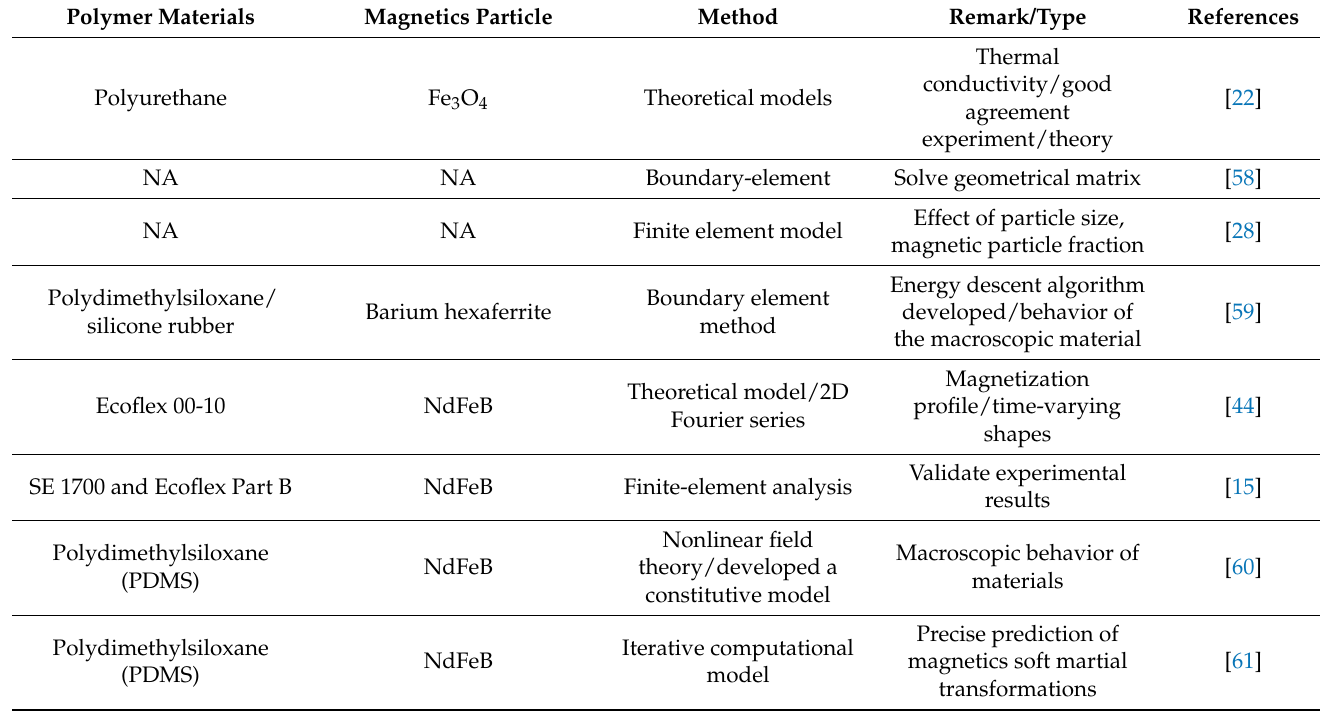
Table 3. Summarized models of MSMP and